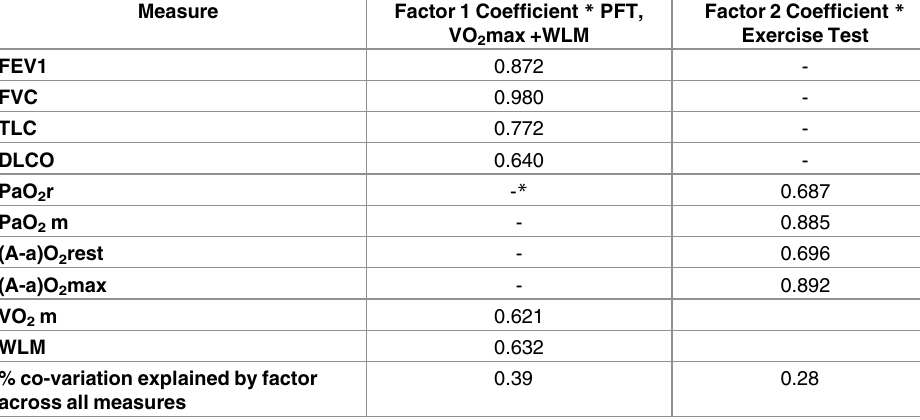
Table 2. Factors and loadings for standardized outcome estimatesat 30 years.